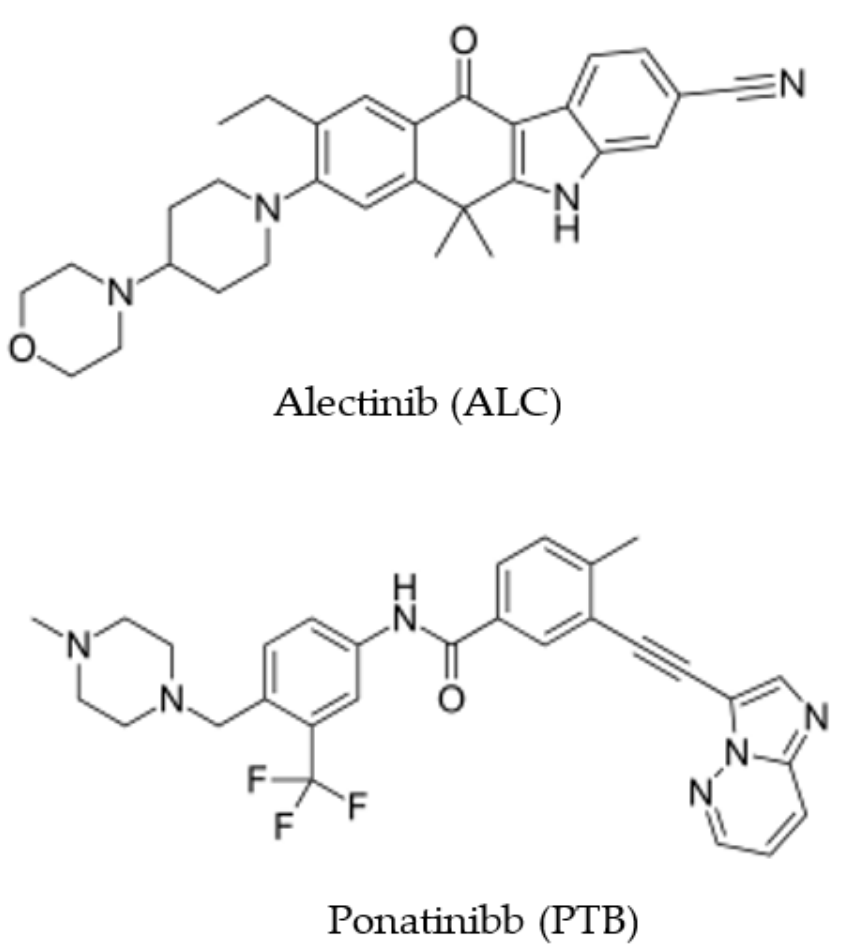
Figure 1. The chemical structures of alectinib (ALC) and ponatinibb